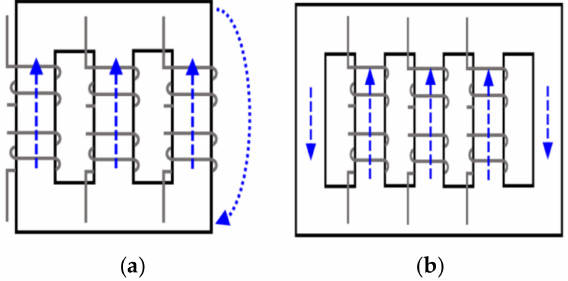
Figure 3. Zero sequence flux of transformer core type. ( a ) Three-limb core-type transformer, and ( b ) five-limb core-type transformer.